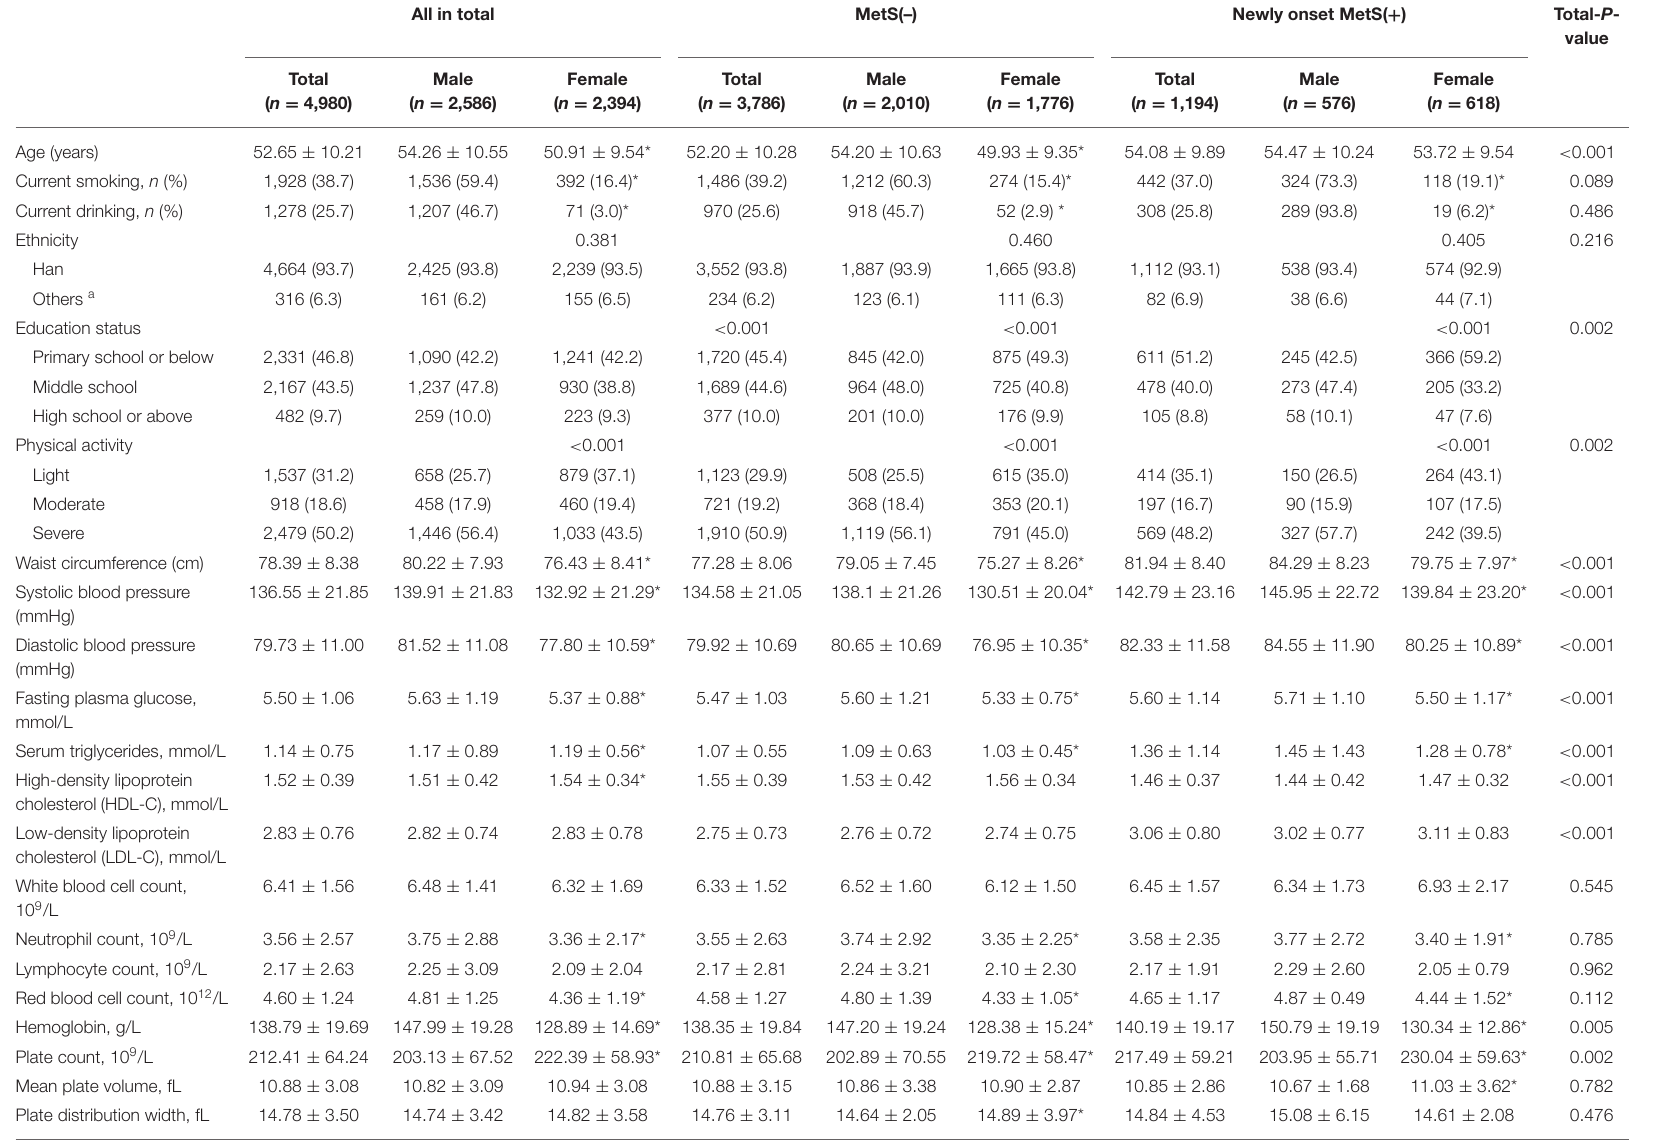
TABLE 3 | Baseline characters of subjects according to metabolic syndrome status at